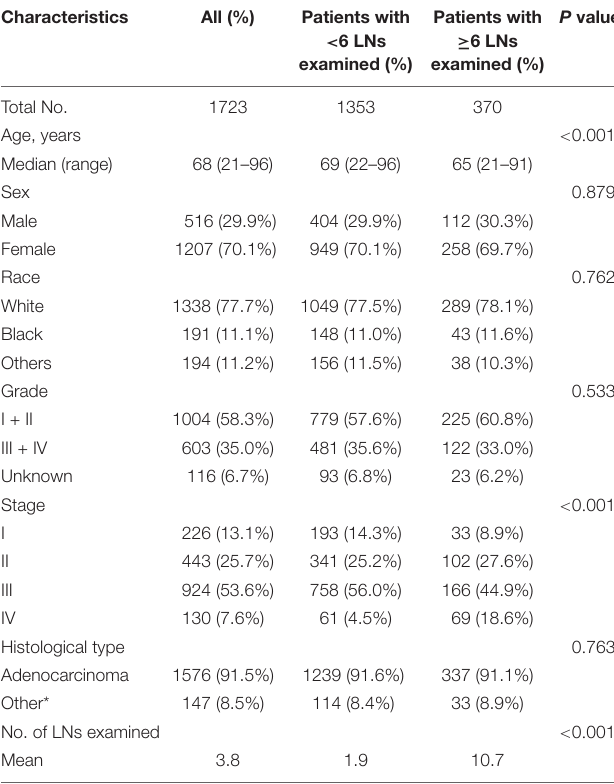
TABLE 1 | Demographic and tumor characteristics for entire